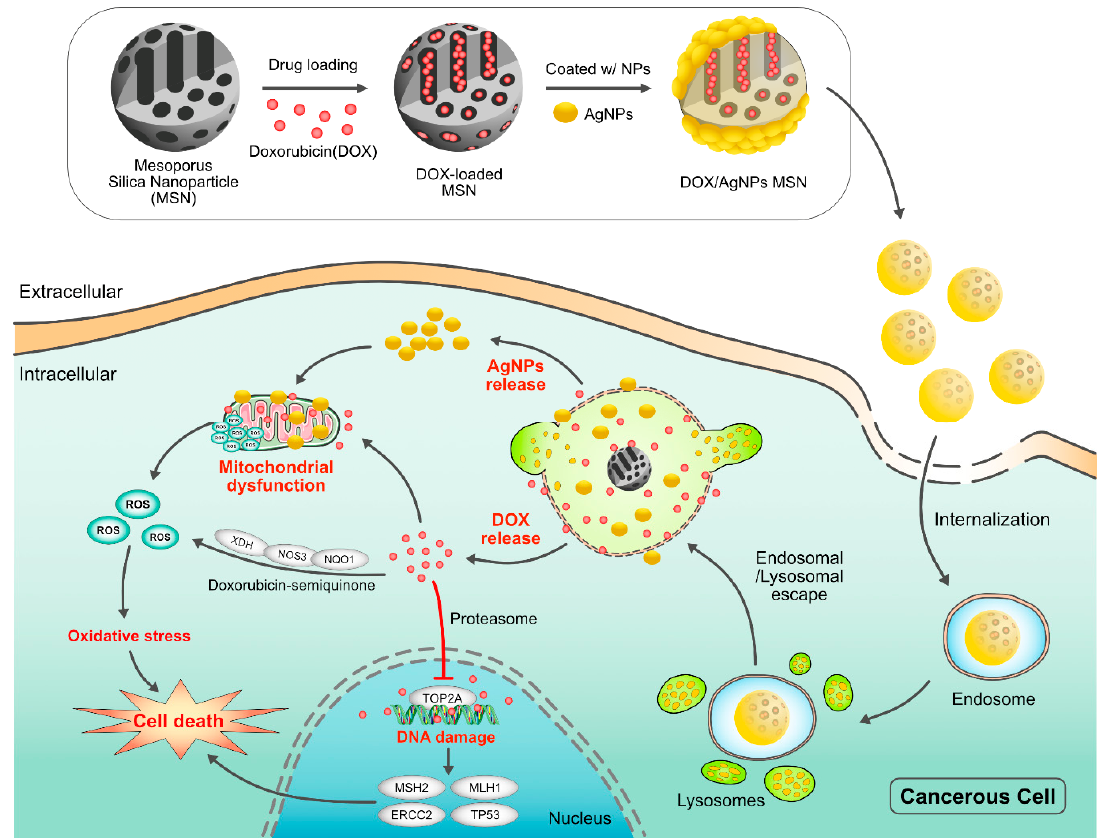
Figure 9. Combined nano-therapy strategy of MSN containing DOX and AgNPs in cancerous cell. MSNs are loaded with DOX then coated with AgNPs. The obtained DOX/AgNPs/MSN is internalized into cancerous cell via endocytosis and then released to cytosol by endosomal pH through endosomal/lysosomal escape. Released AgNPs resulted in mitochondrial dysfunction by inducing ROS production in mitochondria. DOX released accelerate ROS production, followed by induce oxidative stress in cytosol via DOX semiquinone. DOX also is intercalated into DNA that results in DNA damaging by poisoning of topoisomerase II. Both of AgNPs and DOX finally induce cancer cell death through oxidative stress by increasing ROS and DNA damaging in nucleus. Black colored indicates direction of pathway and red color indicates blocking function.